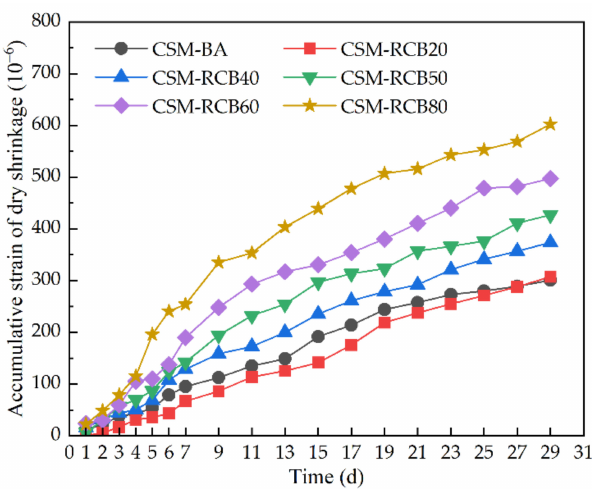
Figure 10. The accumulative strain of dry shrinkage changing with time.